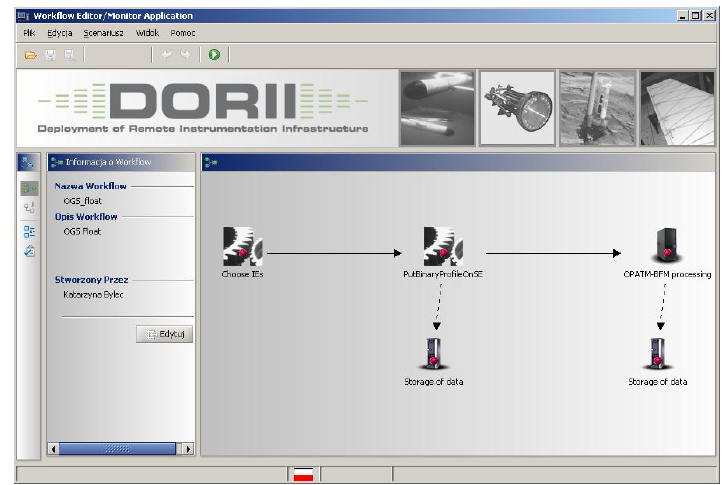
Fig 3. Snapshot from the Workflow Editor with workflow relative to OCOM-MOON application. Fig. 3. Snapshot from the Workflow Editor with workflow relative to OCOM-MOON